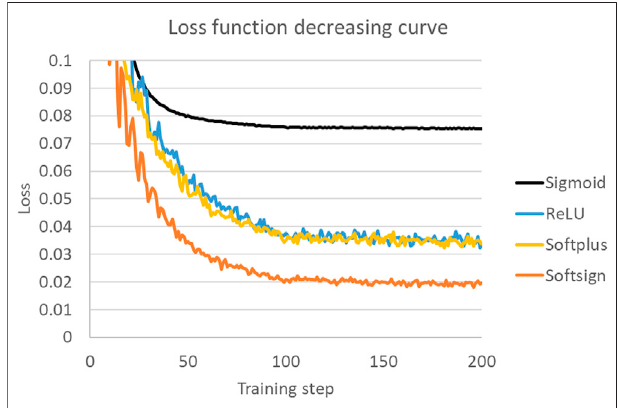
FIGURE 8 | Loss function decreasing curve with different number of nodes. FIGURE 9 | Loss function decreasing curve with different activation